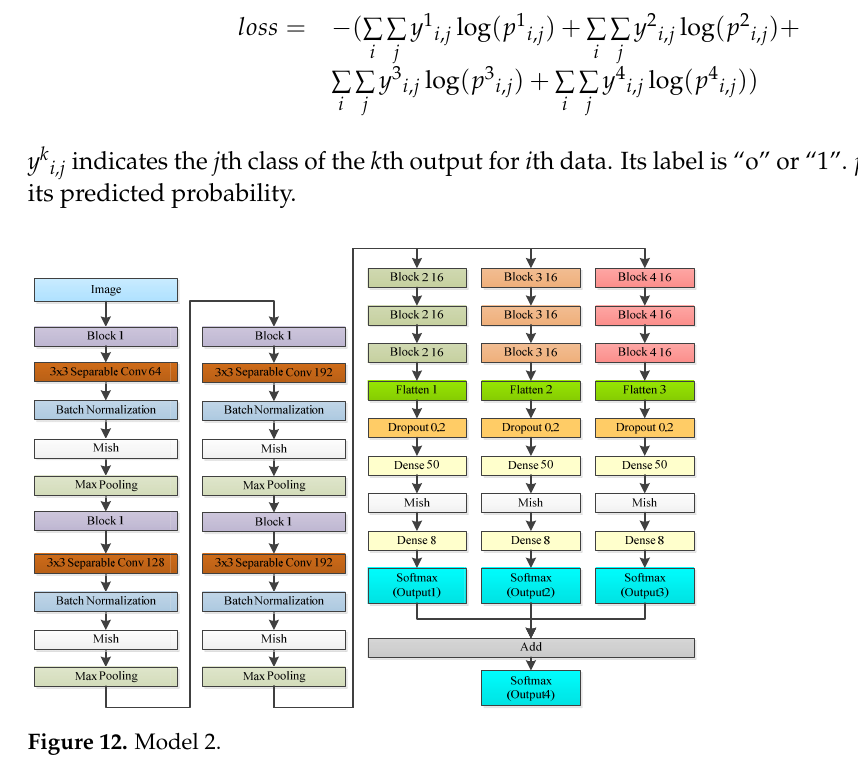
Figure 11. Model 1.